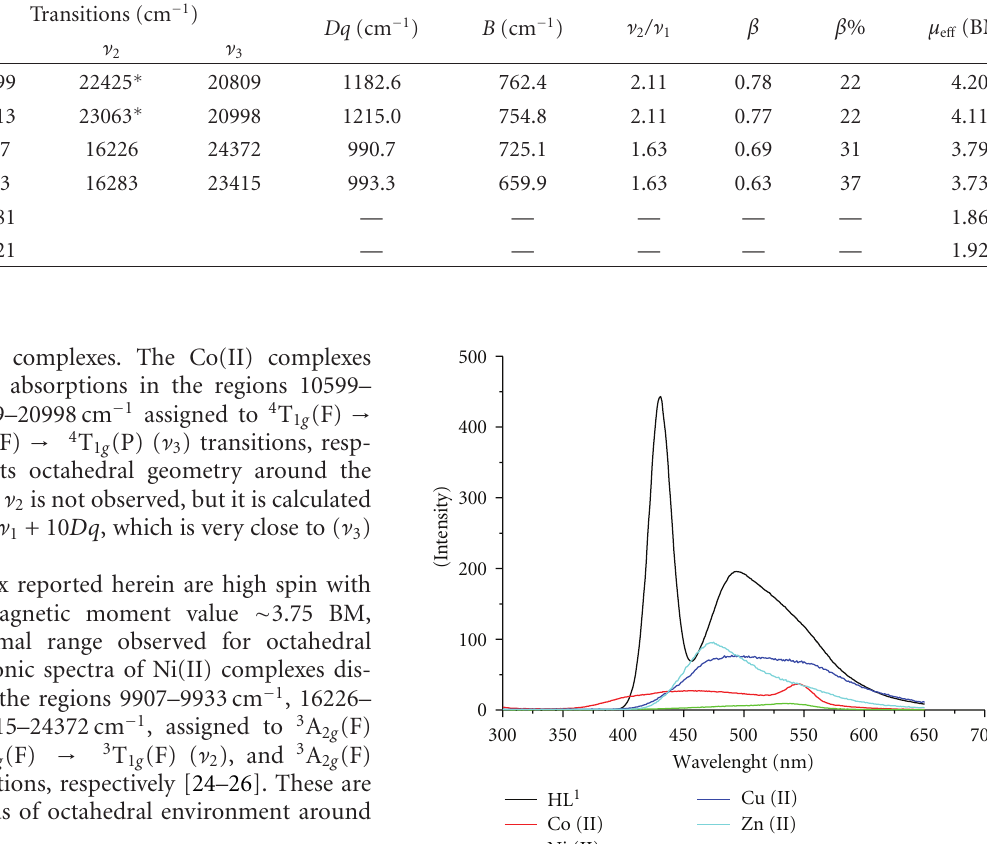
Table 3: Electronic spectral data (in DMF) and ligand field parameters of metal complexes. Compound